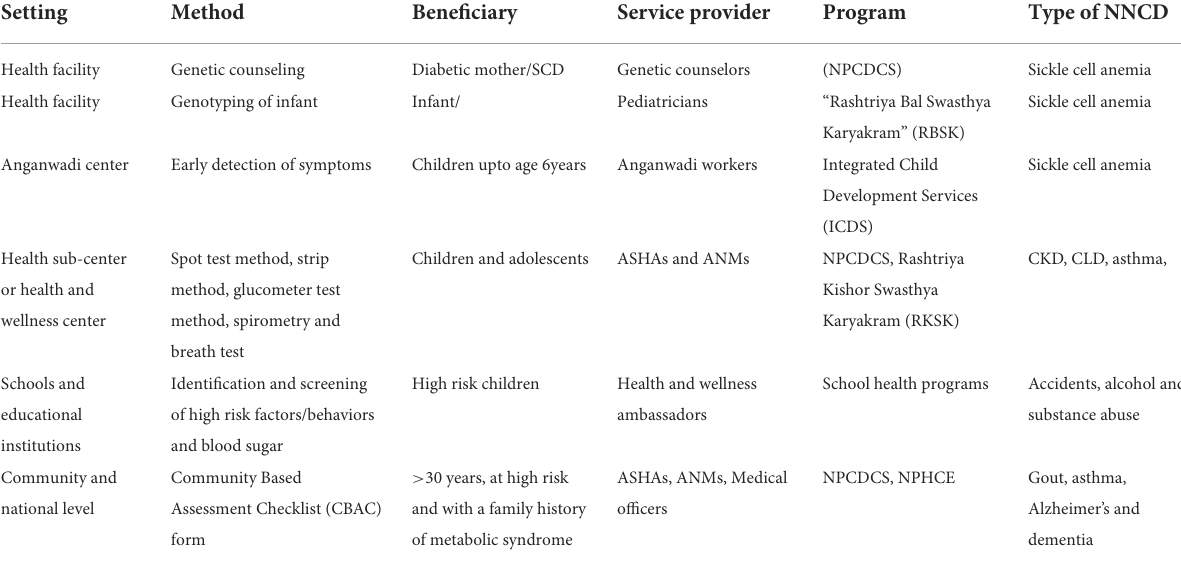
TABLE 1 Proposed solution for tackling NNCDs through existing health programs.